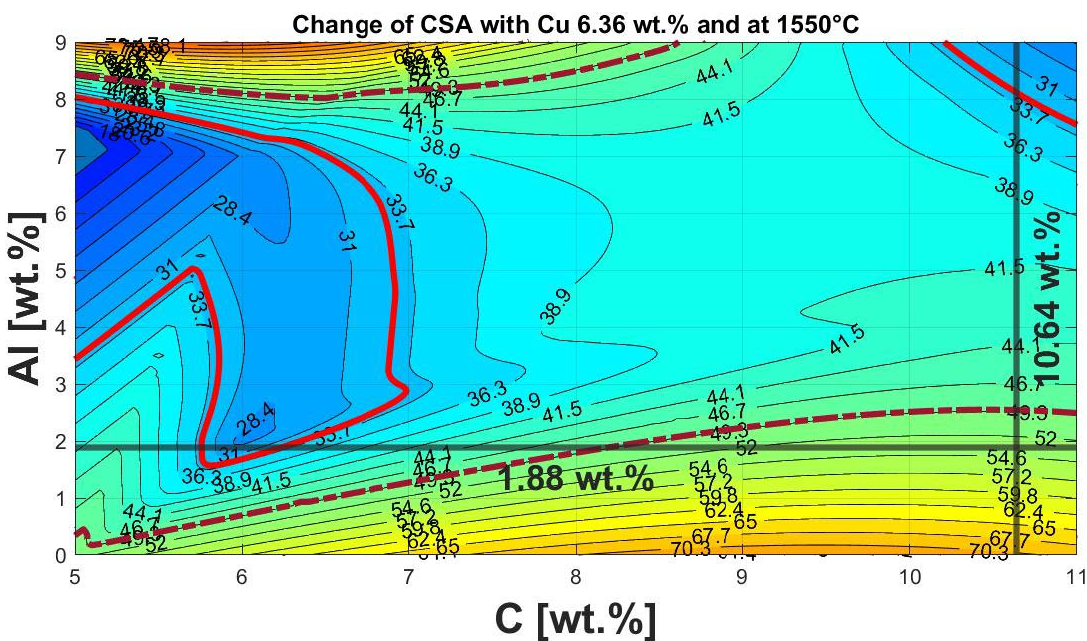
Figure 14. Height stratification diagram of the Al-C-NCA system at constant Cu content of 6.36 wt.% at 1550 °C.